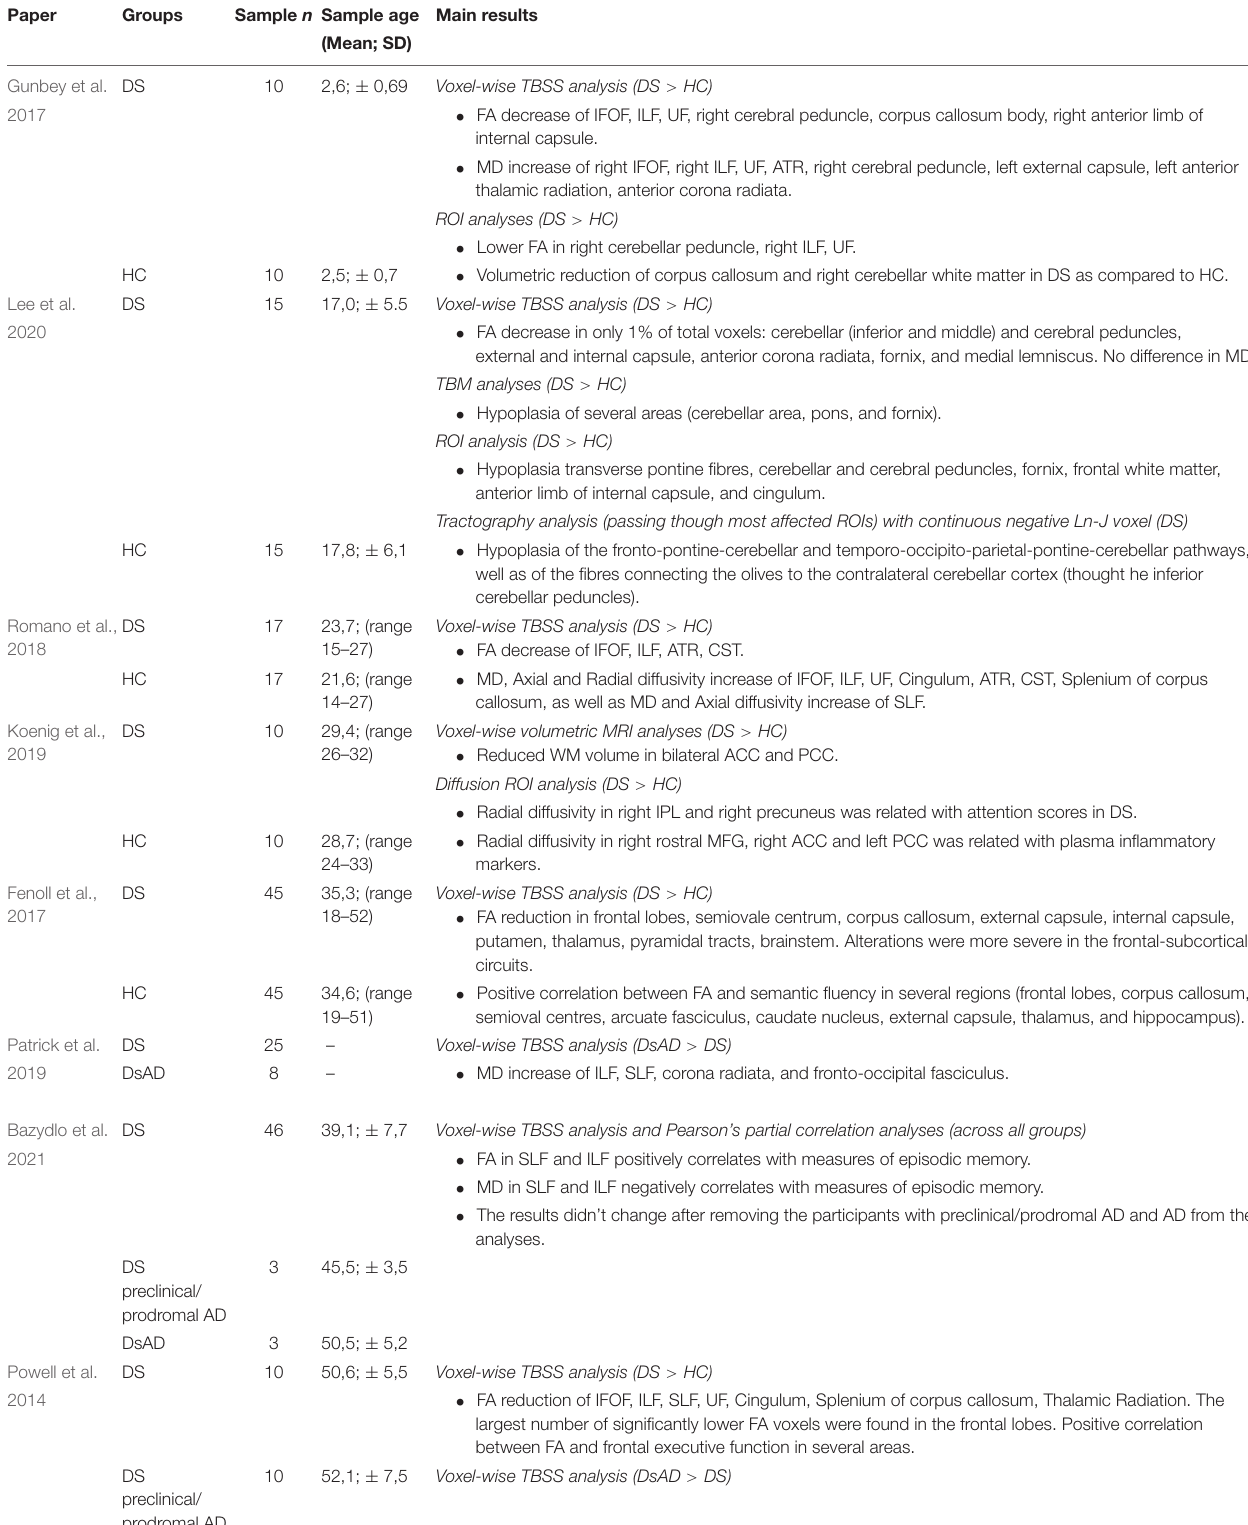
TABLE 2 | Principal characteristic and main results of diffusion imaging studies in Down syndrome. Paper